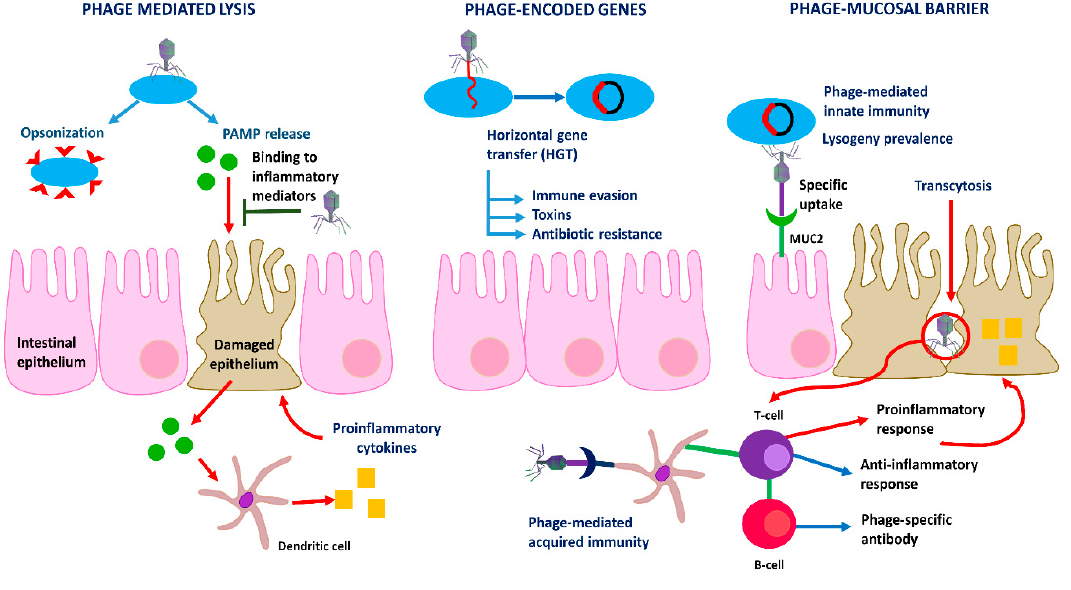
Figure 2. Bacteriophage-mediated immune responses.